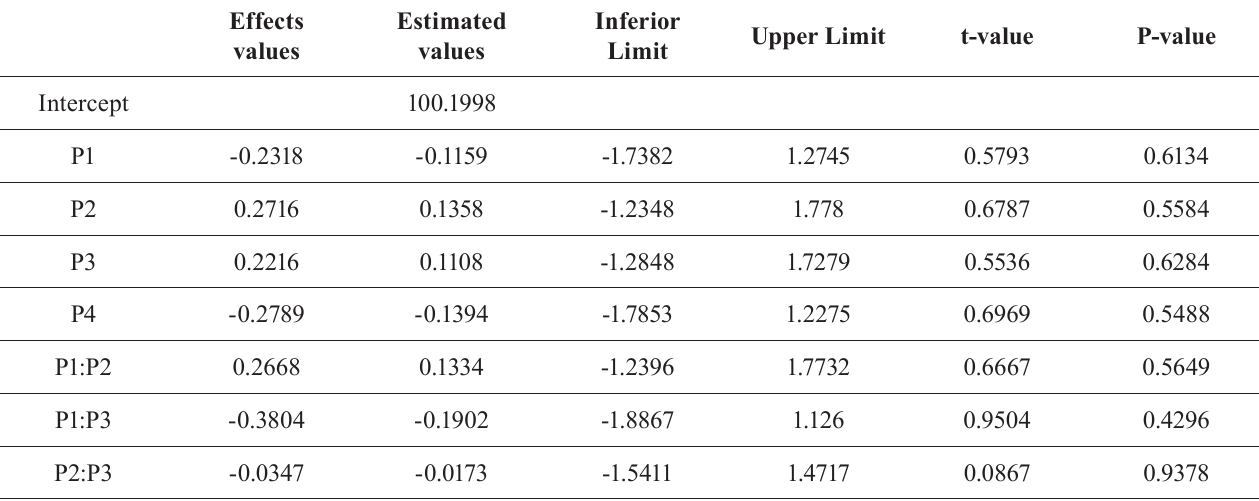
TABLE VIIIA - Values of effects: estimated, limit, and Student’s t-test for rutin